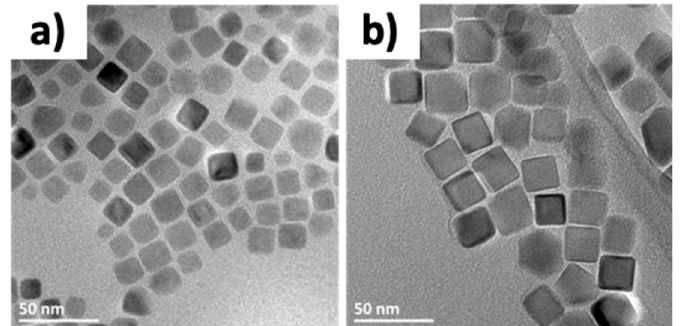
Figure 2. Transmission electron microscopy (TEM) images of nanocubes synthesized from FeSt 3 using adapted Kovalenko protocol ( a ), and using the optimized protocol ( b ).